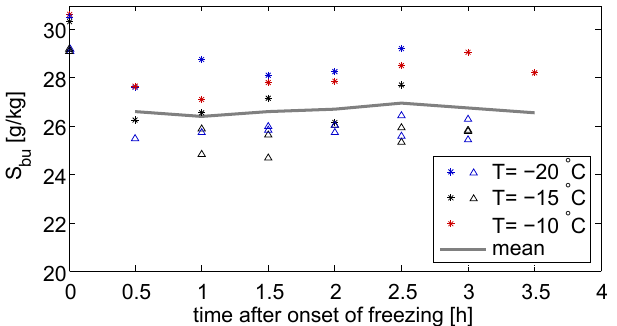
Fig. 7. Temporal evolution of the bulk salinity in the experiments with waves (triangle) and with current and wind (stars) at different air temperatures. The initial salinity for each experiment is indicated at the origin of the time